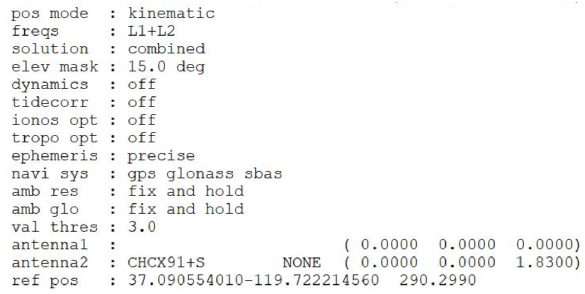
Fig. 4. Data processing parameters used in RTKLIB.